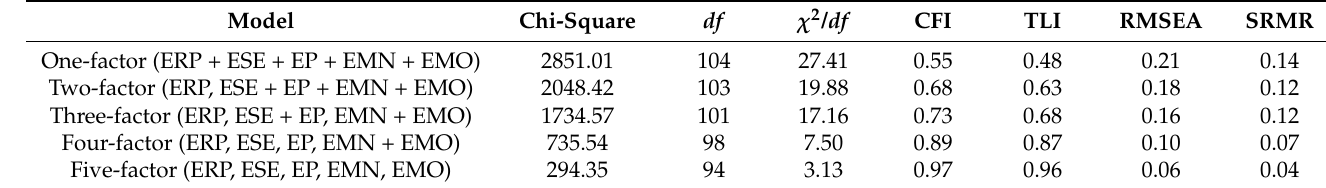
Table 2. Confirmatory factor analysis results of discriminant validity of variables.